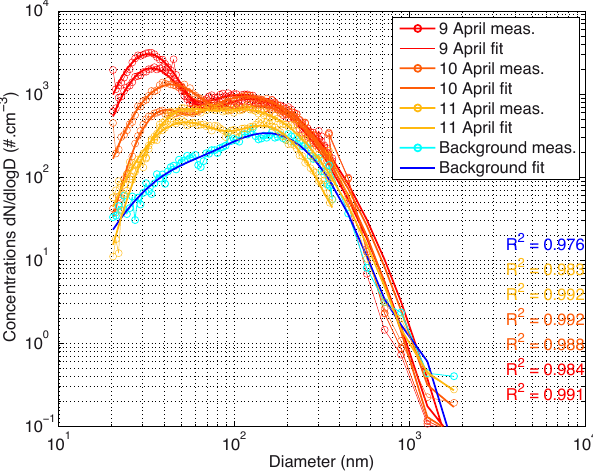
Fig. 4. Anthropogenic aerosol size distributions measured (thin solid line with circles) and fitted (thick solid line) for flights on April 9, 10 and 11 coloured in red, orange and yellow, respectively. A typical background size distribution encountered in non polluted air masses is shown in blue. Distributions are fitted with a 3 log-normal parameterisation, corresponding correlation factors are